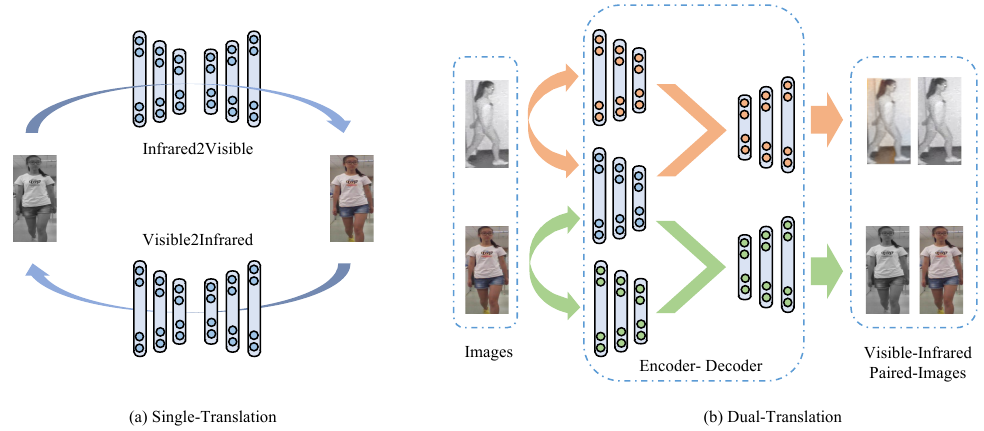
Figure 7. Three kinds of widely used methods in the literature. ( a ) Infrared to visible [11,53] and visible to infrared [12,54]; ( b ) more works generate visible-infrared image pairs, employing their combination